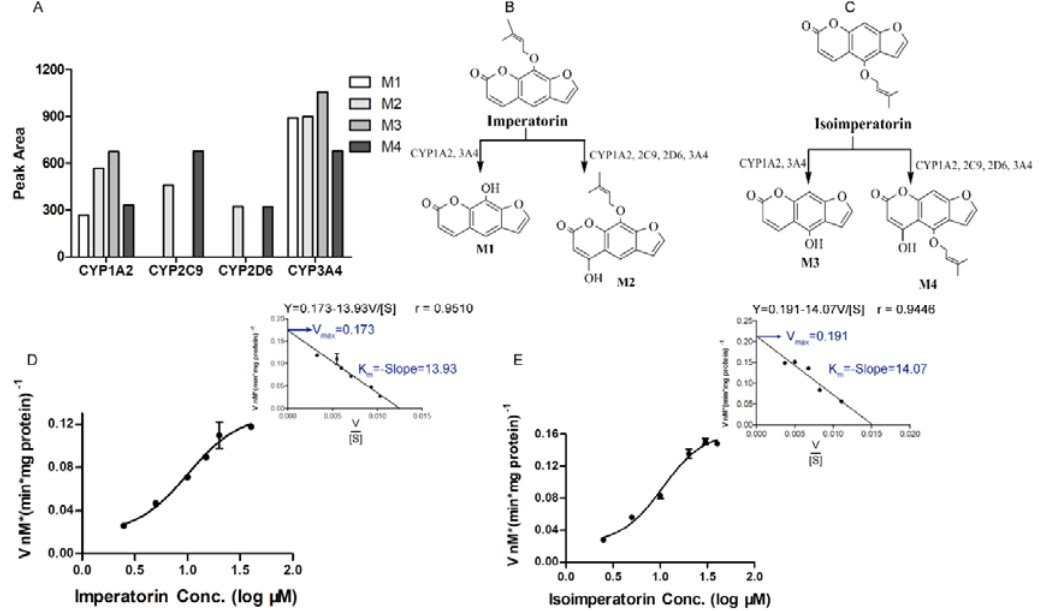
Figure 5. Metabolic pathway and metabolic kinetic constant information of imperatorin and isoimperatorin in human liver microsomes. ( A ) 50 μ M Imperatorin (or isoimperatorin) was incubated with recombinant CYP450s, and the relative quantity of metabolite M1, M2, M3 and M4 were determined by the peak area of extract ion chromatograms. ( B , C ) Summary of imperatorin and isoimperatorin metabolic pathways. ( D , E ) Imperatorin (or isoimperatorin) metabolites formation rate vs. its parent drug Log concentrations (in accordance with the Michaelis–Menten saturation curve) and their K m and V max in human liver microsomes were calculated from the Eadie–Hofstee plot (inset).